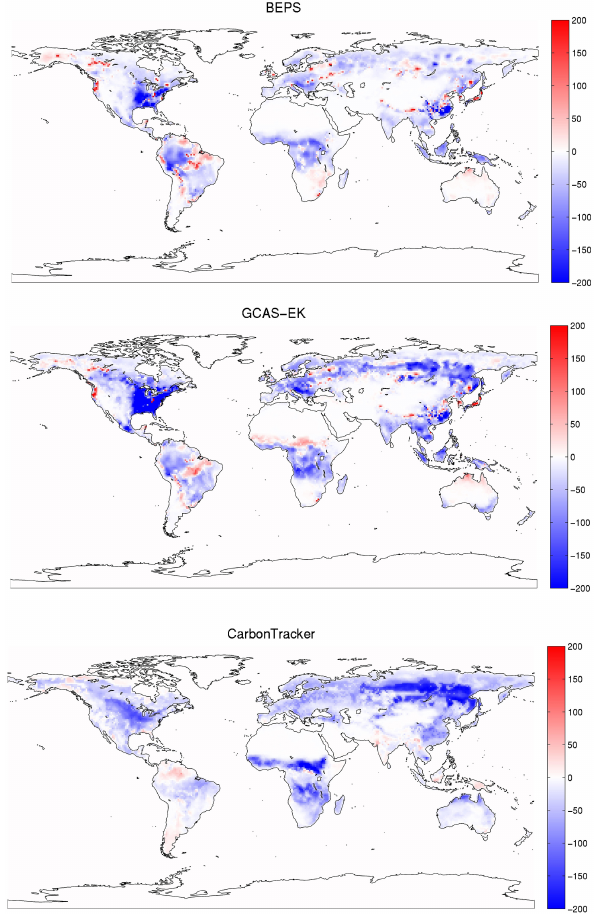
Figure 7. Global carbon budget (gCm − 2 ) distributions on mul- tiyear average from 2002 to 2008: prior carbon fluxes simulated by BEPS; assimilated carbon fluxes by GCAS-EK; CarbonTracker 2011 estimated carbon fluxes.